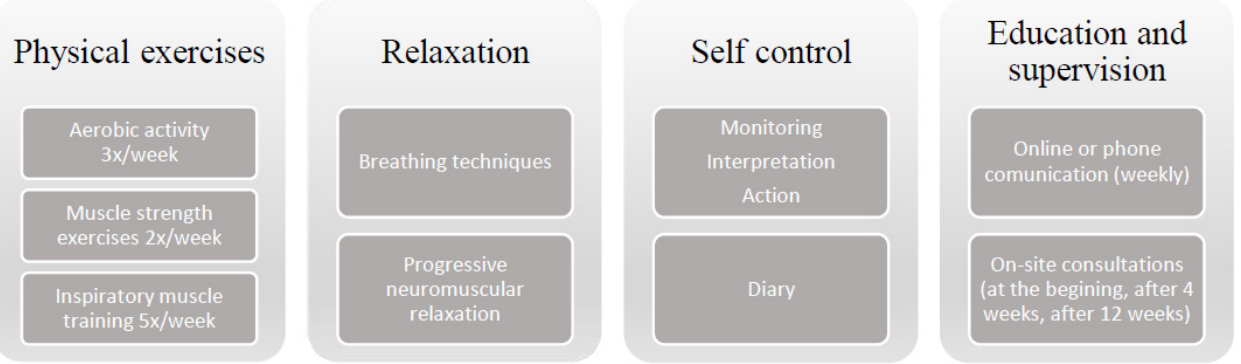
Figure 1. The physiotherapy program content.